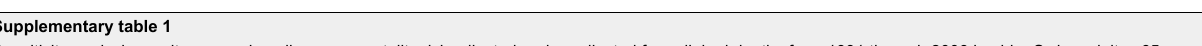
Supplementary table 1 Sensitivity analysis results comparing all-cancer mortality risk adjusted and unadjusted for unlinked deaths from 1991 through 2008 in older Swiss adults ≥65 years old. Characteristic